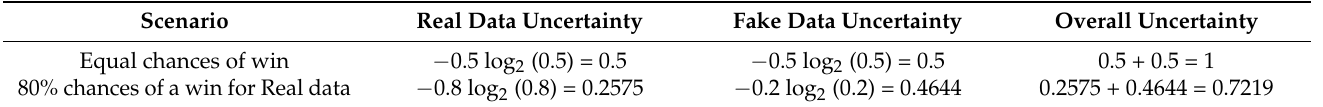
Table 2. Sample of decision tree selection based on the probability of